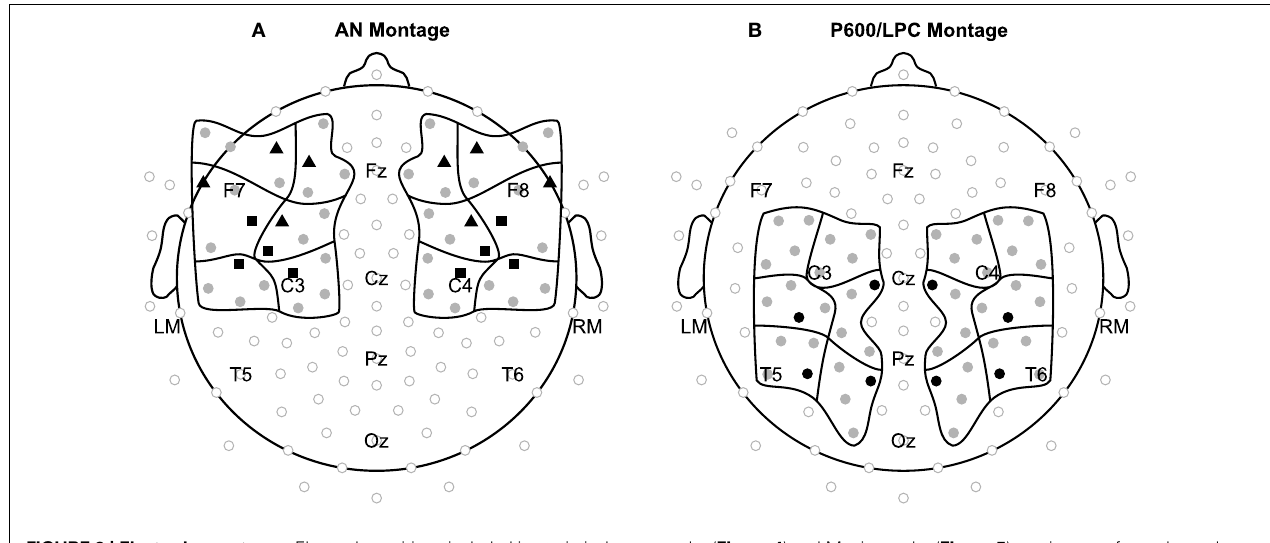
FIGURE 2 | Electrode montages. Electrode positions included in statistical analyses for the (A) AN and (B) P600/LPC are shown in black and gray grouped into 12 regions of interest.Waveforms shown in the Language